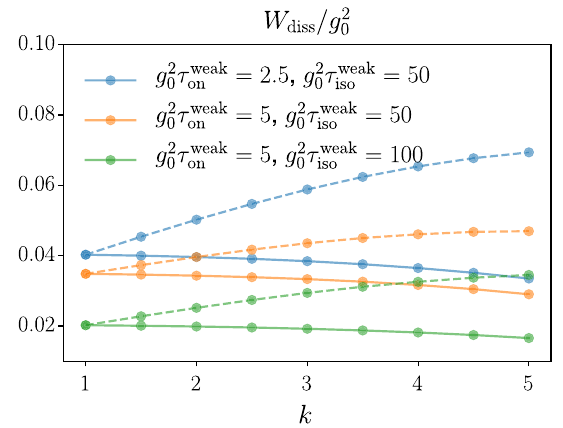
over an entire protocol in the RL FIG. 10. Decay of the optimal dissipated work as a function of diss the total protocol time in the RL model. The optimal k for each τ τ weak =k 2 , while the is found following the procedure discussed below Eq. (32). iso ¼ tot iso Circles show numerical results, lines indicate power-law fits on ¼ τ k 2 τ weak C τ ν to the function W (solid lines). Parameters are . Parameters are ε on ¼ diss ð tot Þ ¼ on tot 0 . 1 , βε 1 , and Λ = ε 100 g 2 0 = ε i ¼ i ¼ i ¼